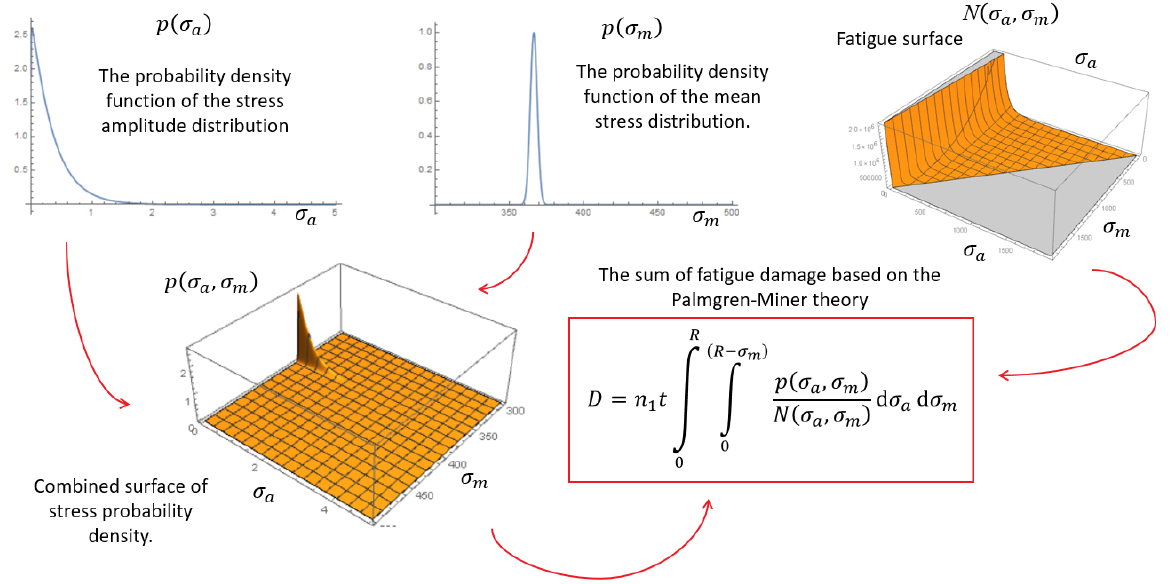
Table 13. Values of the failure accumulation parameter D .